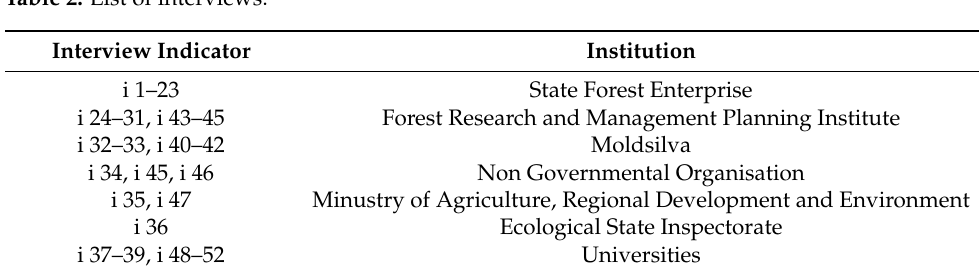
Table 2. List of